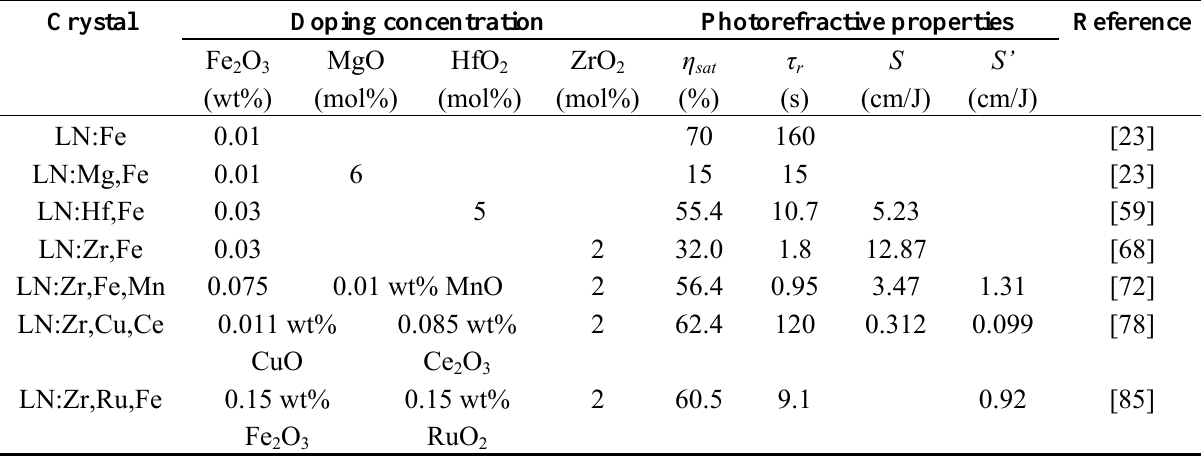
Table 2. Photorefractive Properties of LN:Fe, LN:Mg,Fe, LN:Hf,Fe, LN:Zr,